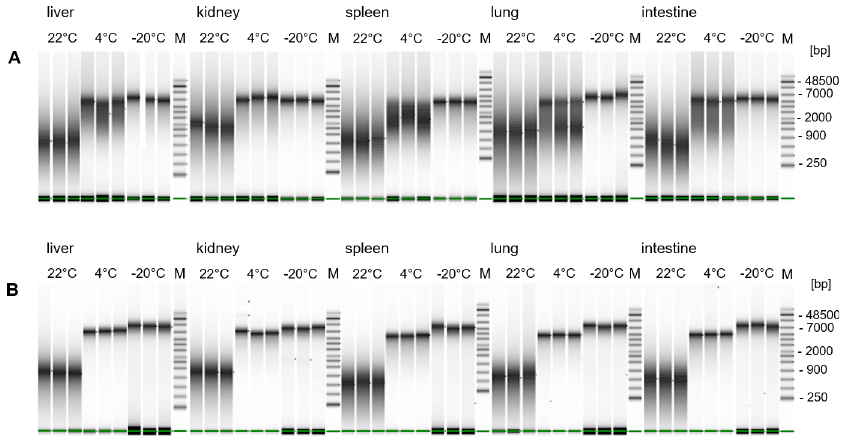
Fig 7. Storage of PET blocks for 9 years at lower temperatures prevents from DNA degradation. Analysis of DNA integrity from FFPE (A) and PFPE (B) tissues of rat liver, kidney, spleen, lung and intestine on Agilent 4200 TapeStation system with genomic DNA Analysis ScreenTape assay. PET blocks were stored prior to DNA extraction for 108 months at 22˚C, 4˚C, and -20˚C. DNA was extracted from 3x 10μm sections in